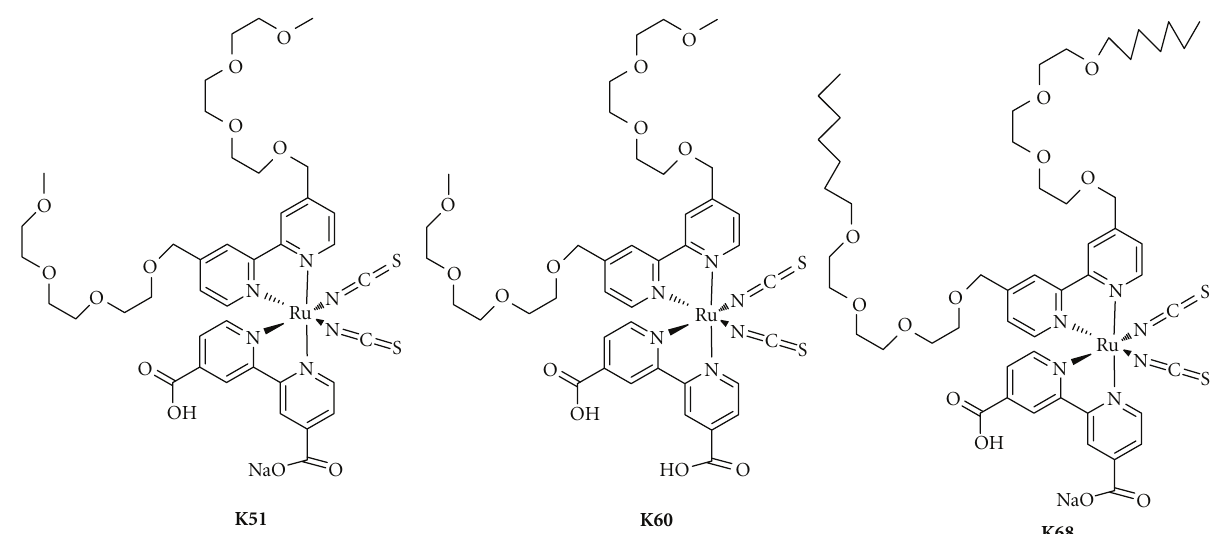
Figure 10: Molecular structures of K51 , K60 , and K68 dyes (taken from